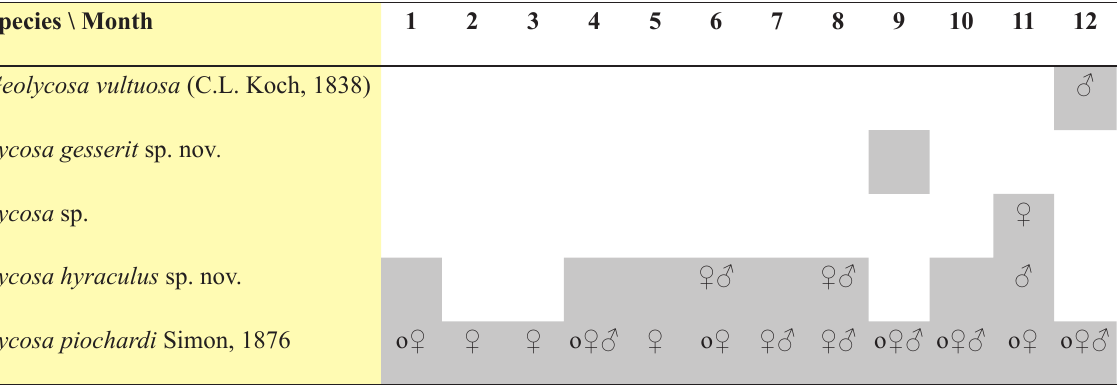
Table 4. Documented activity of Lycosa Latreille, 1804 and Geolycosa Montgomery, 1904 in Israel (by month). Females with egg-sacs marked by ‘o’. Grey squares without a sex sign denote juveniles